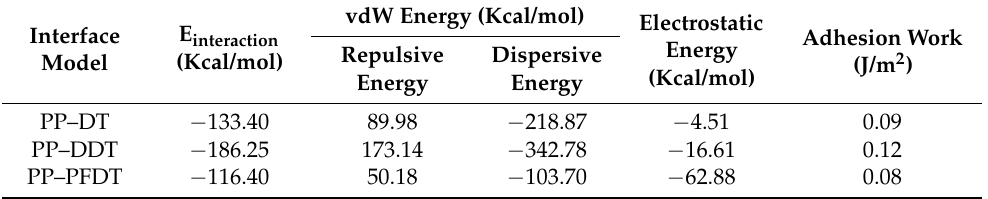
Table 4. Interaction energy and adhesion work in three interface models in the C (2 × 2) arrange- ment.